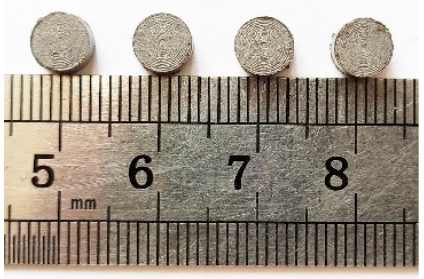
Figure 8. The physical diagram of PTFE/Al/Si samples for dynamic mechanical properties test.